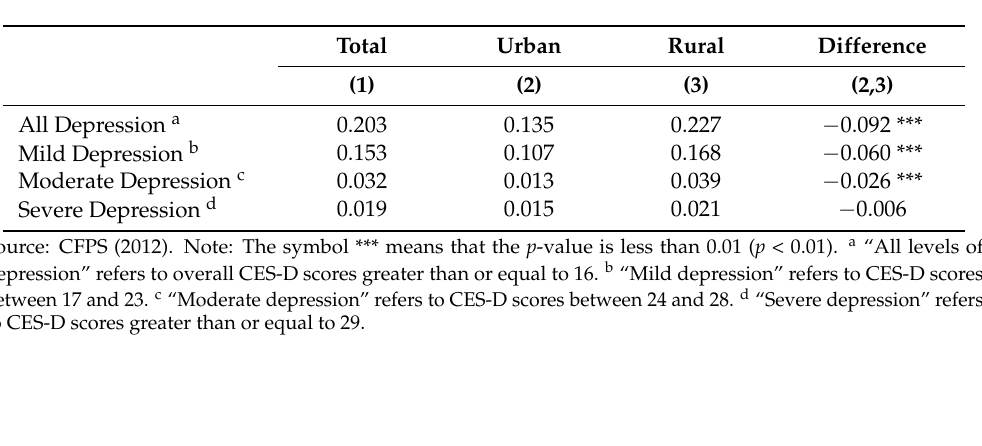
Table 2. The proportion of sample children with different levels of depression severity—CFPS